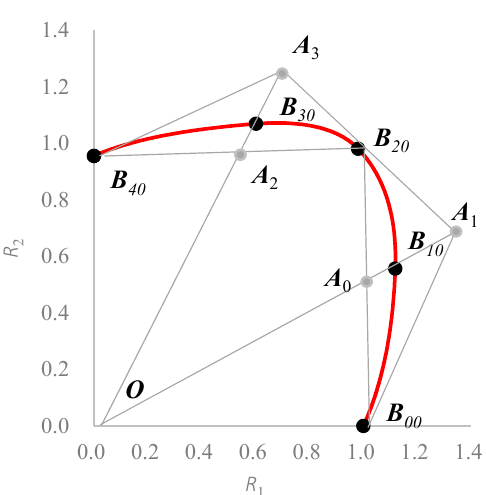
Figure 3. Locations of A 1 – A 3 and B i 0 which are used as parameters p k and q k .